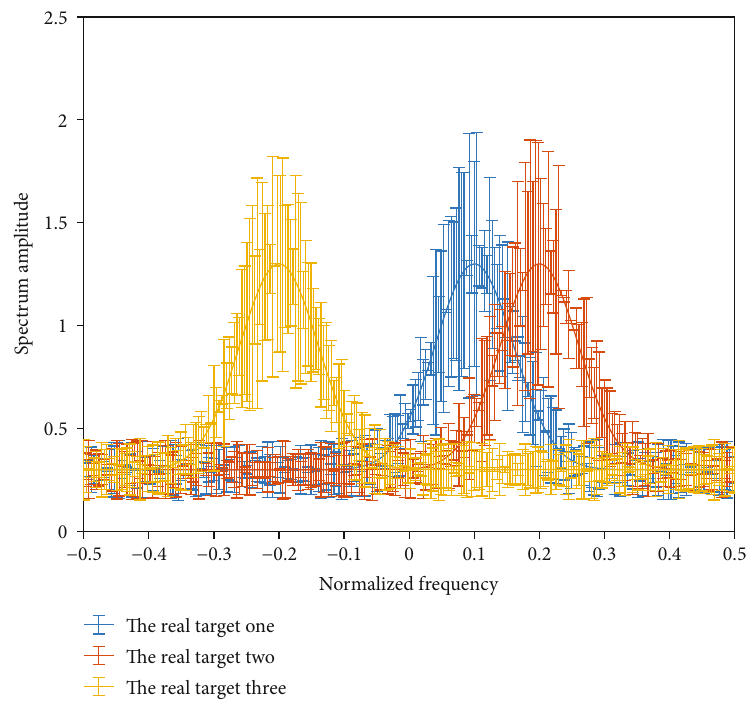
Figure 4: Fuzzy model of multiple